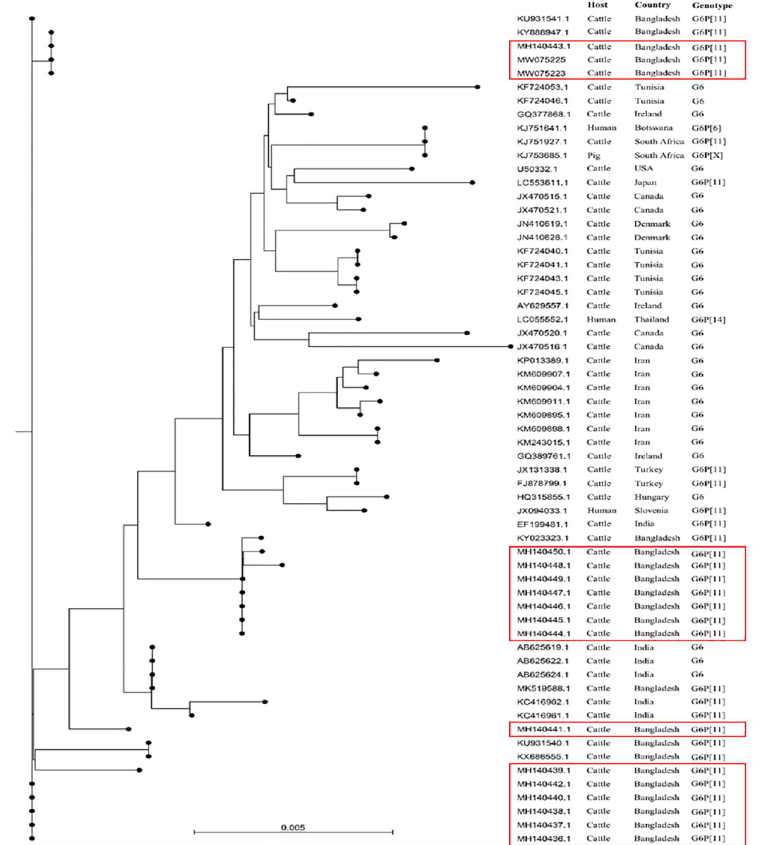
Fig 3. The evolutionary relationship of G6-VP7 genes of bovine rotaviruses detected in the present study (red rectangle). The tree was constructed with the aligned sequences downloaded through BLAST search. The relationship was inferred using the Neighbor-Joining method and the ecleotide distances were measure using Kimura 80 model on CLC Sequence viewer 8.0. The scale bar at the bottom indicates nucleotide substitutions per site.